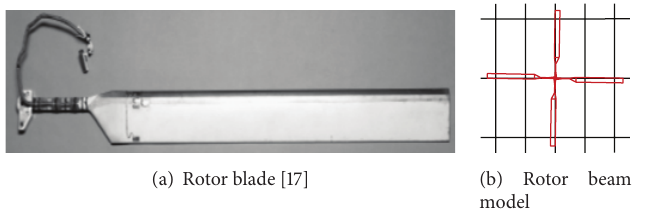
Figure 5: Isolated rotor blade and beam